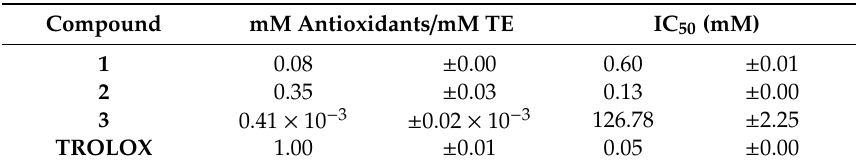
Table 5. Antioxidant activity and IC 50 values of free thiadiazole ligands 1 – 3 and TROLOX after 30 minutes of reaction with DPPH · radicals ( ± standard deviation (SD) calculated from experiments carried out in